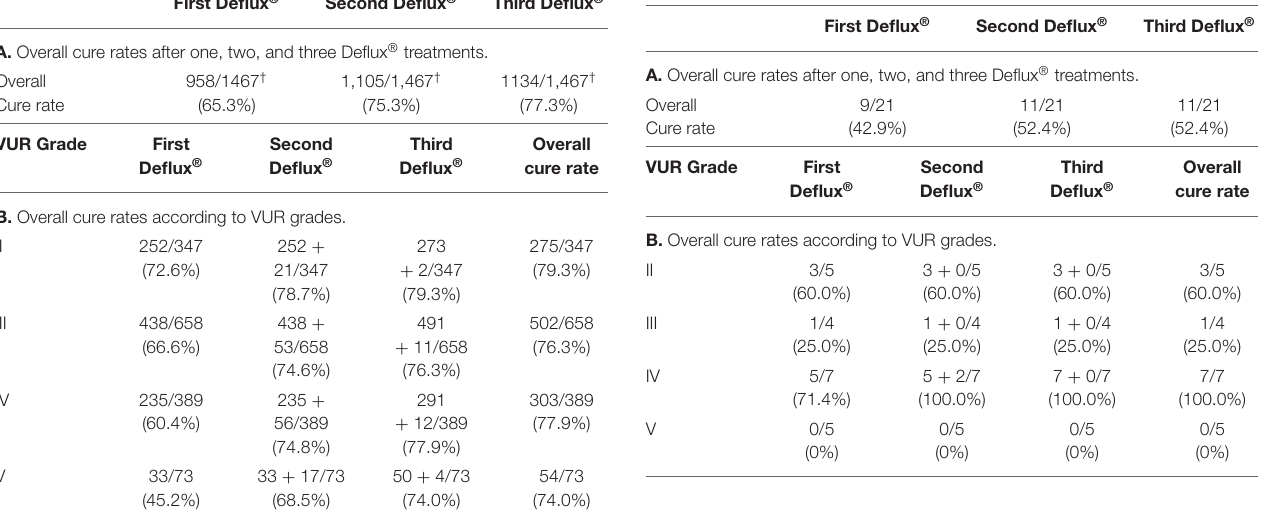
TABLE 2 | Resolution of vesicoureteral reflux (VUR) per ureter after Deflux ® (paraureteral diverticulum cases). First Deflux ® Second Deflux ® Third Deflux ® A. Overall cure rates after one, two, and three Deflux ®